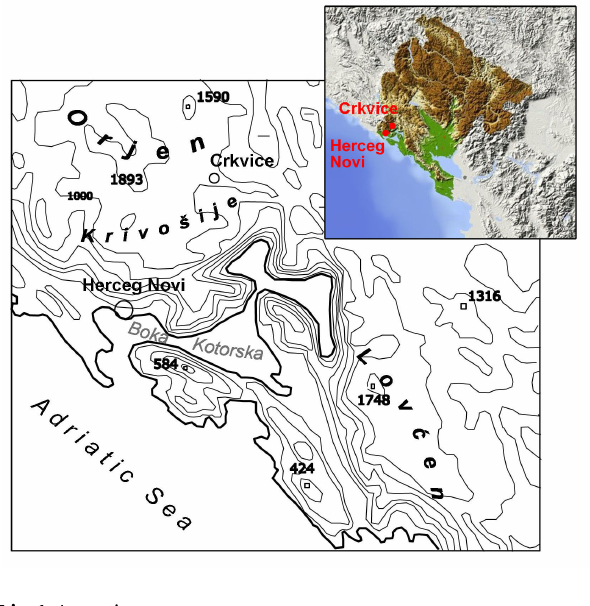
Fig. 1. Location map.